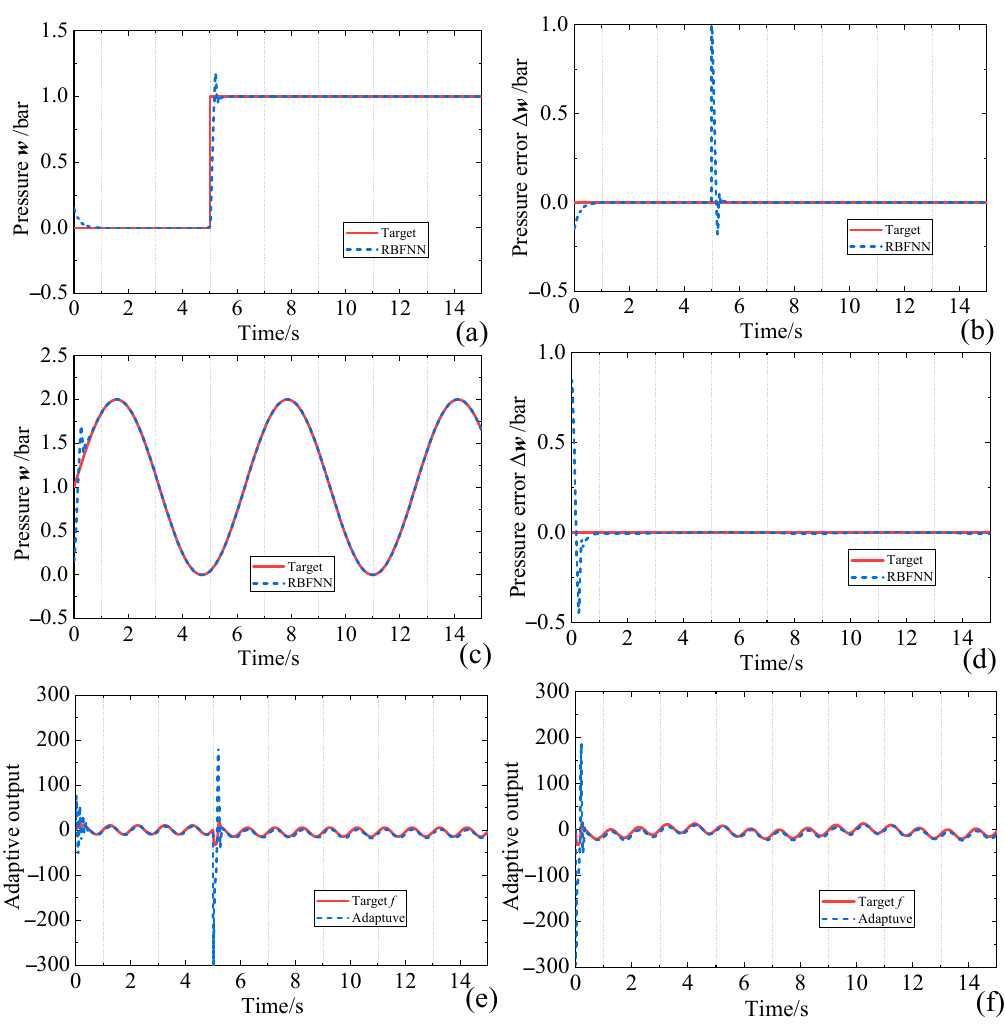
Figure 17. Adsorption system control results. ( a , b ) Pressure control and tracking errors in step signals. ( c , d ) Pressure control and tracking errors in sinusoidal signals. ( e , f ) Adaptive parameter changes based on adaptive laws in step and sinusoidal signals.